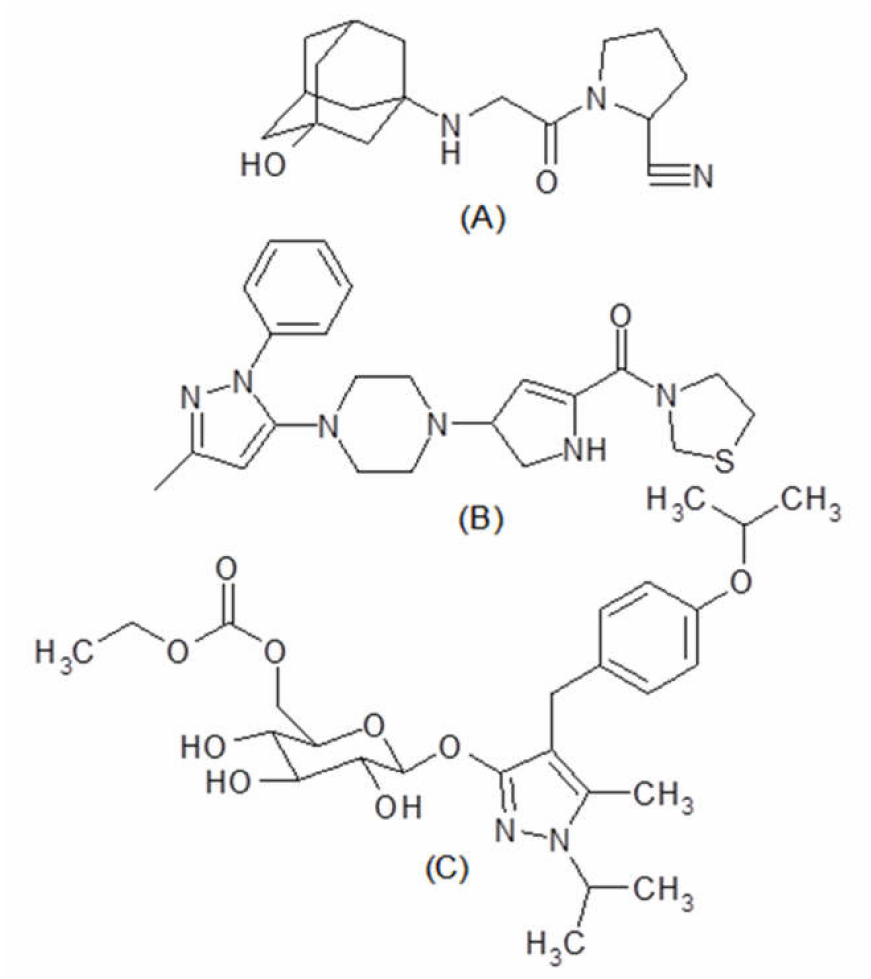
Figure 1. Chemical structure of vildagliptin ( A ), teneligliptin ( B ), and remogliflozin etabonate ( C